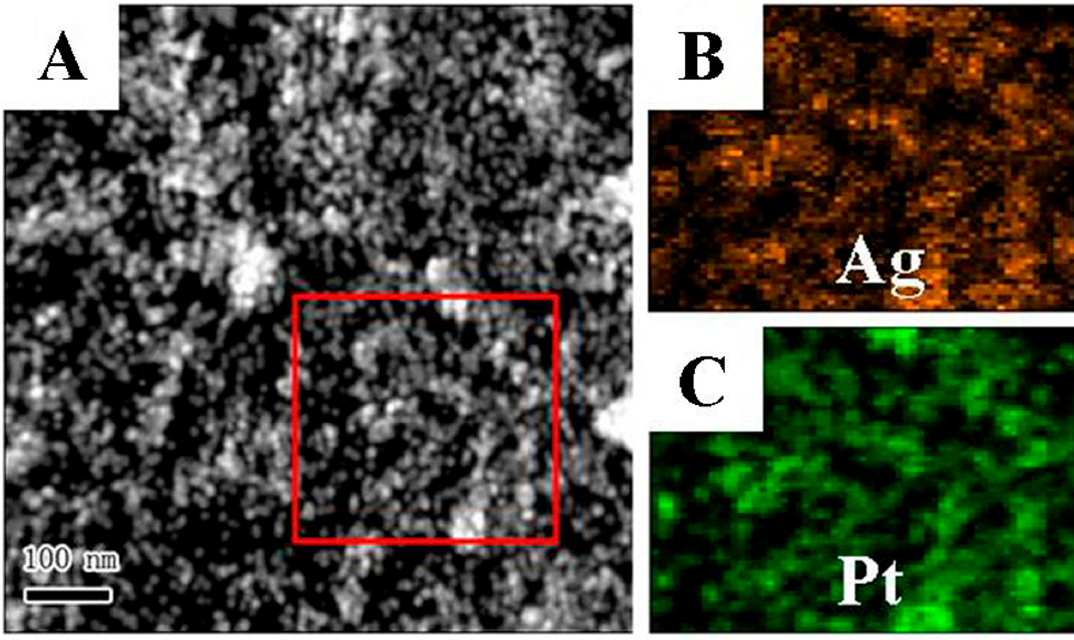
Figure 3. High-angle annular dark-field scanning transmission electron microscopy (HAADF-STEM) images for Pt-Ag/GNs ( A ); elemental mapping images for Ag ( B ) and Pt ( C ).